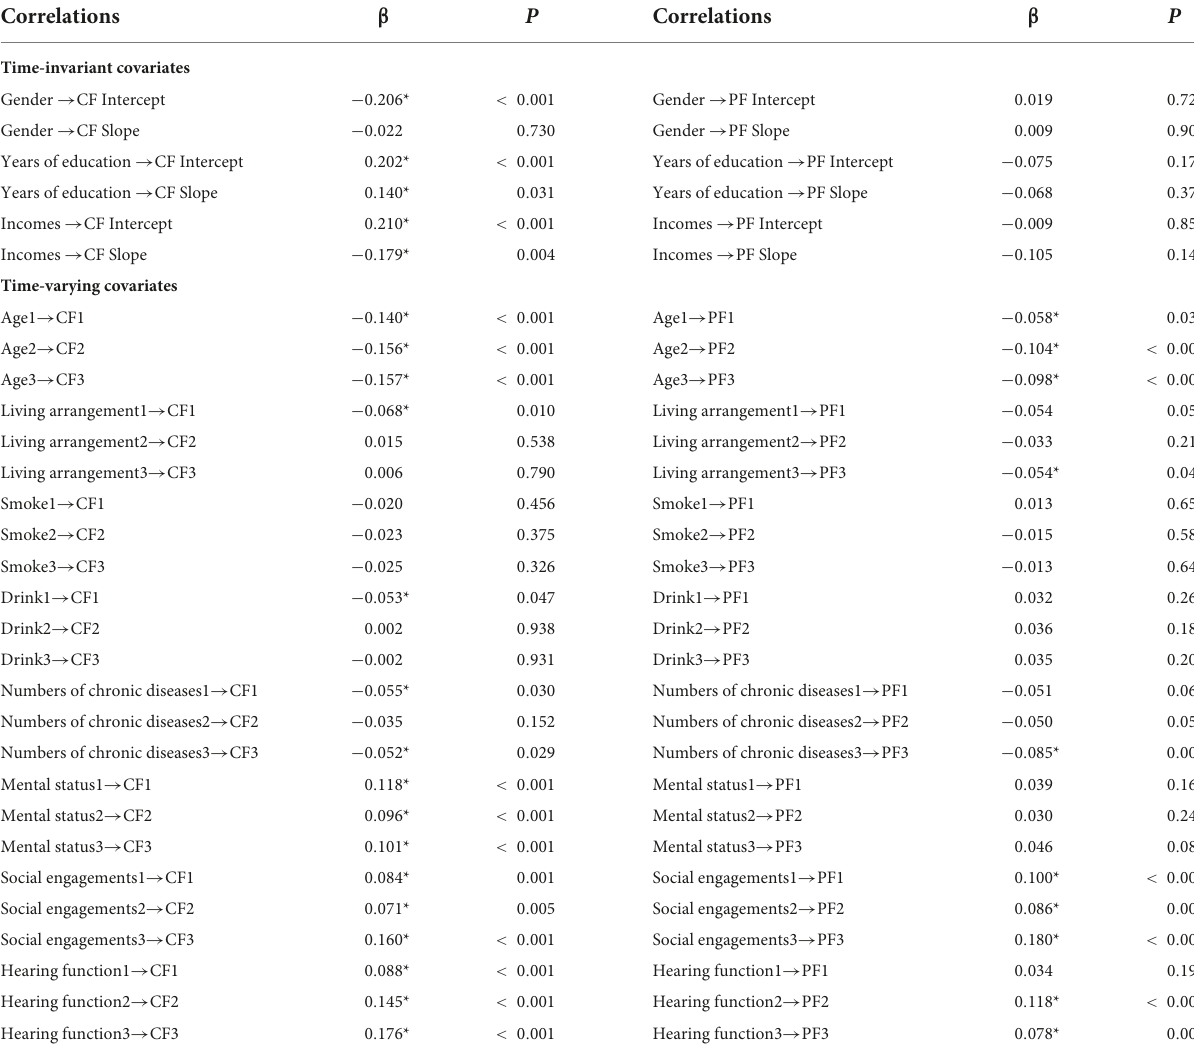
TABLE 4 Standardized coefficients for covariates in the conditional parallel process latent growth